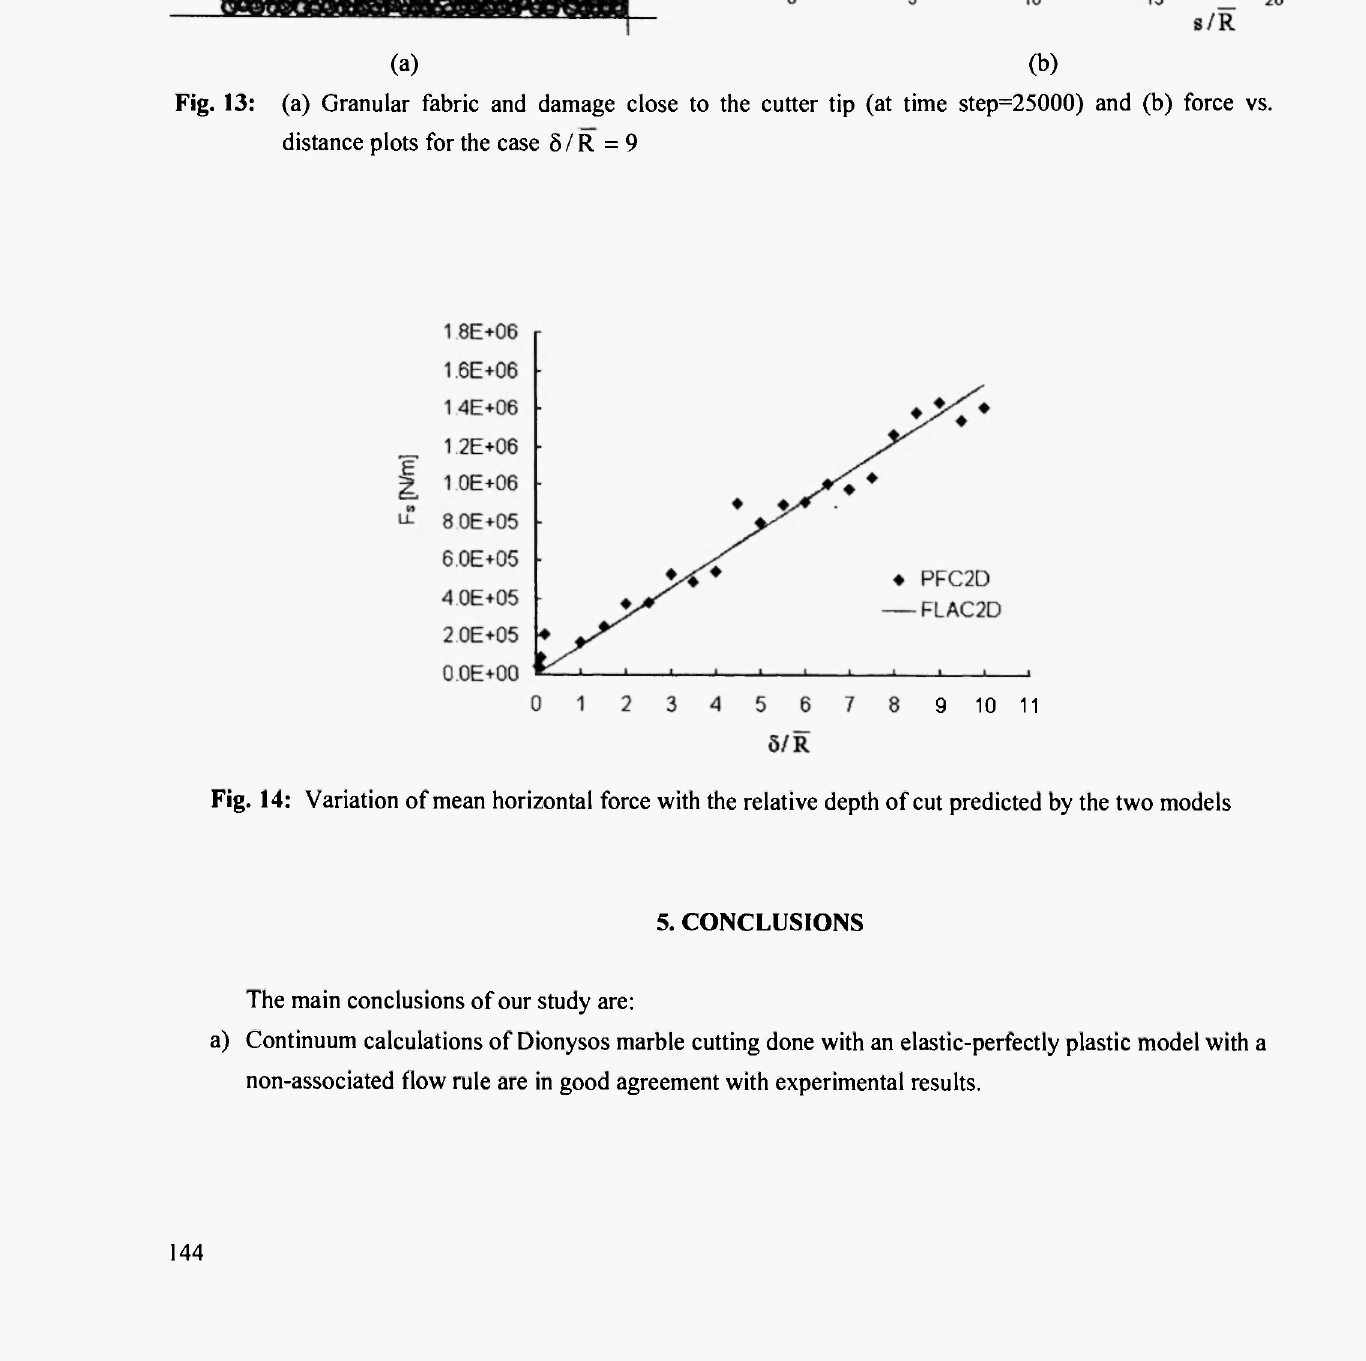
(a) Granular fabric and damage close to the cutter tip (at time step=25000) and (b) force vs. distance plots for the case δ / R = 9